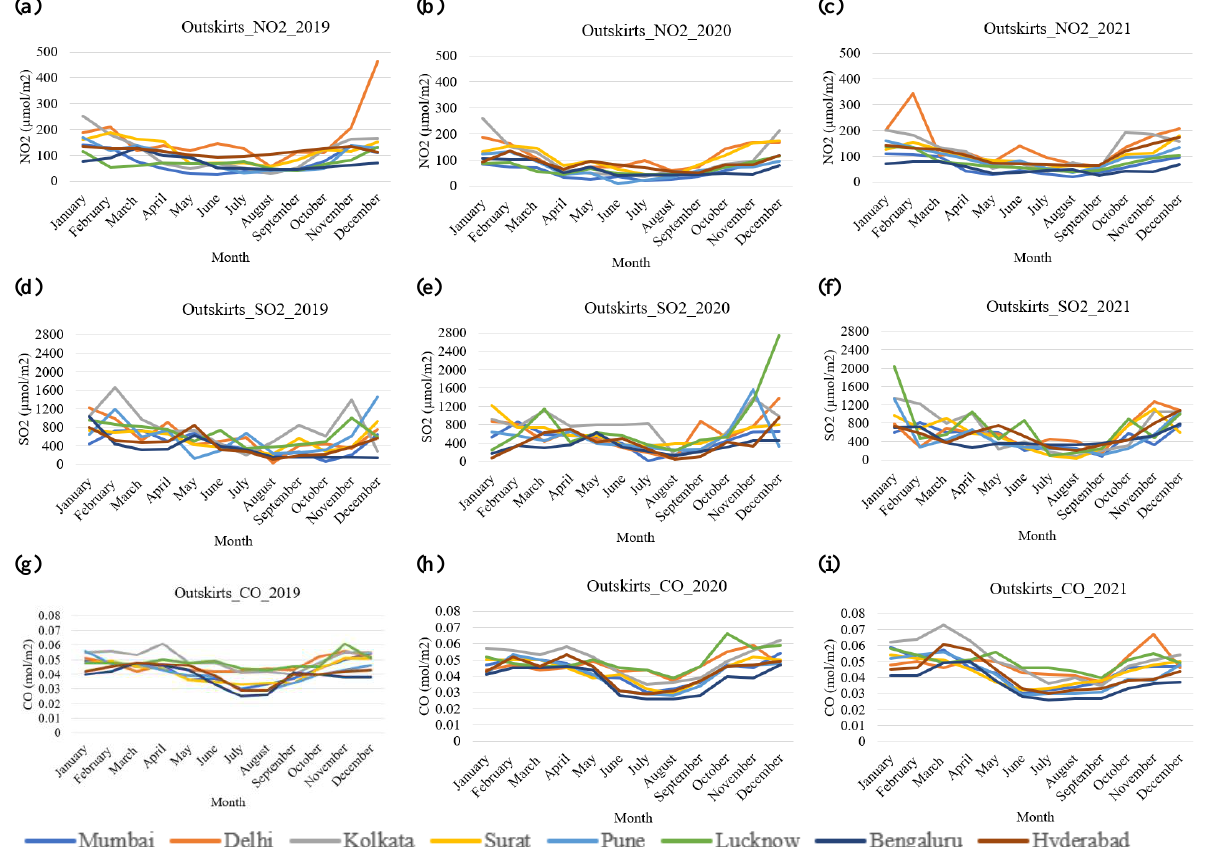
Figure 4. Pollutants concentration in outskirts area of